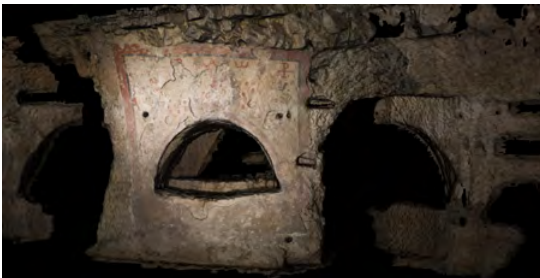
Figure 1. Example of image based reconstruction,